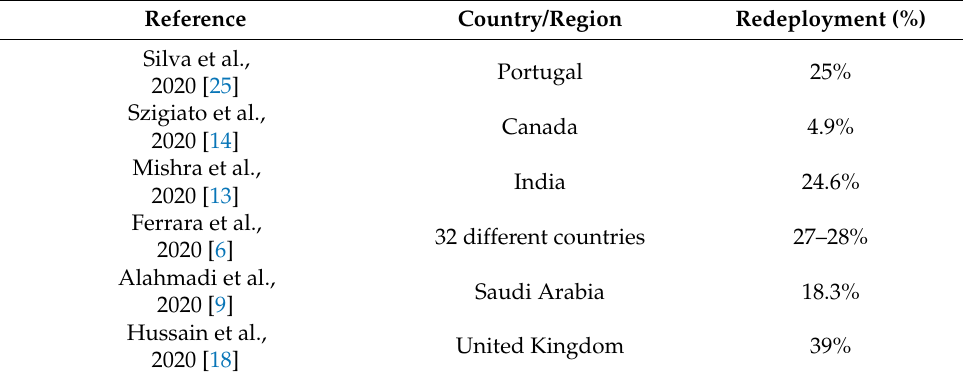
Table 2. Percent of ophthalmology trainees redeployed to areas of need. Reference